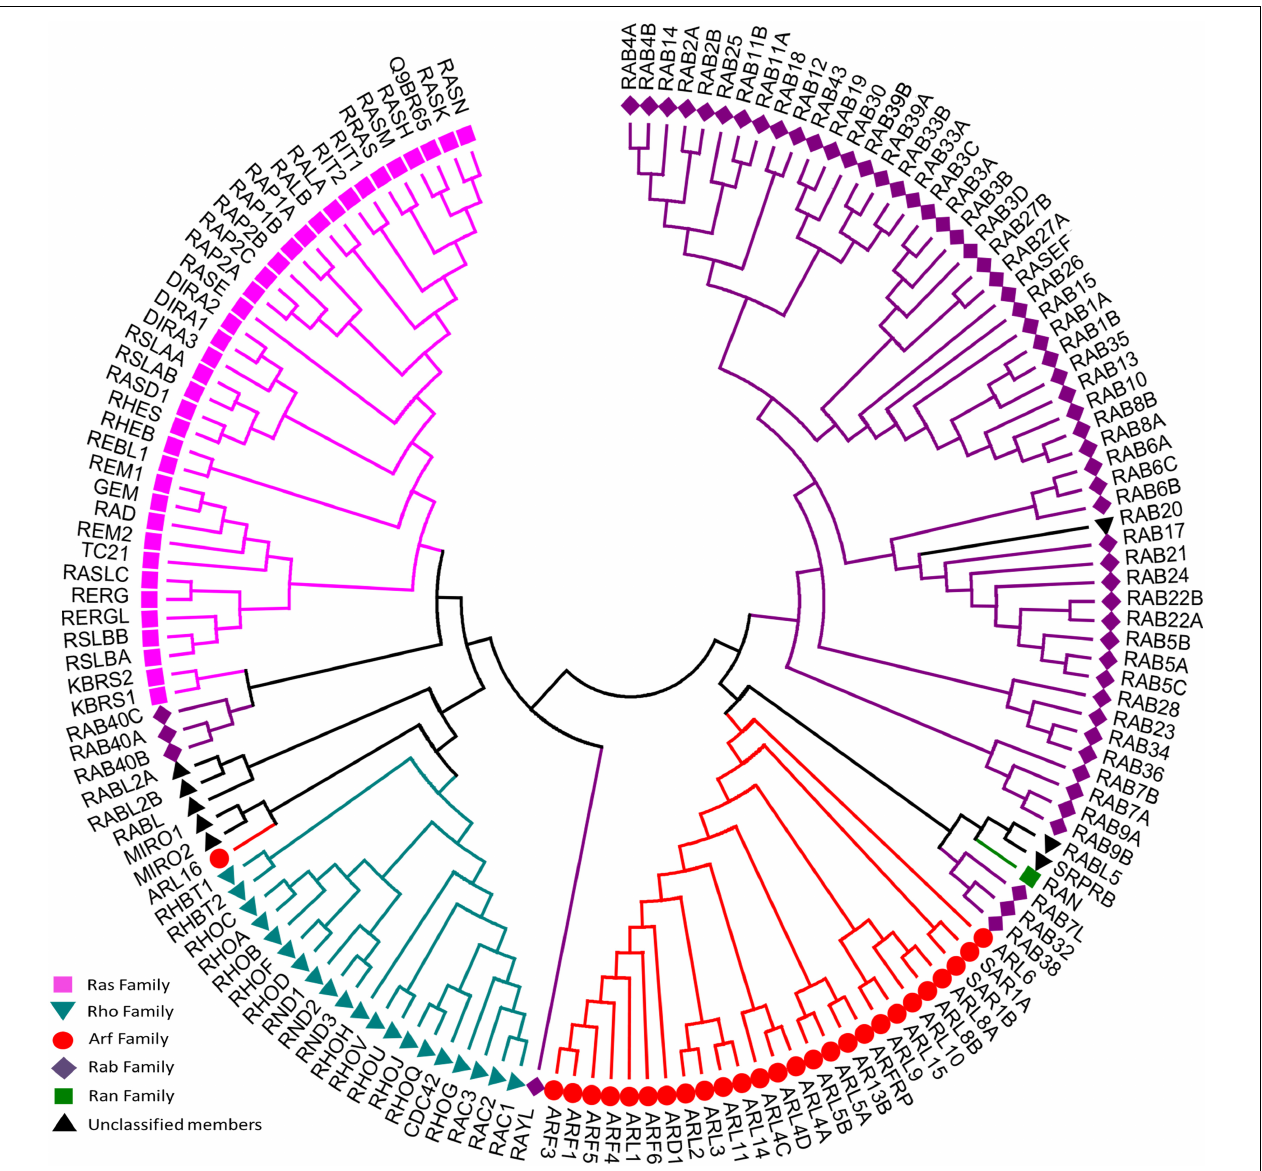
FIGURE 2 | Evolutionary relationships of human Ras superfamily. The evolutionary history was inferred using the Neighbor-Joining method. After removing identical sequences, 162 amino acid sequences ( Supplementary Table S1 ) are used for the analysis. All ambiguous positions were removed for each sequence pair. The original classification was indicated by different colors: Ras (lilac), Rho (cyan), Rab (purple), Arf (red), Ran (green), and Unclassified members (blank). Evolutionary analyses were conducted in